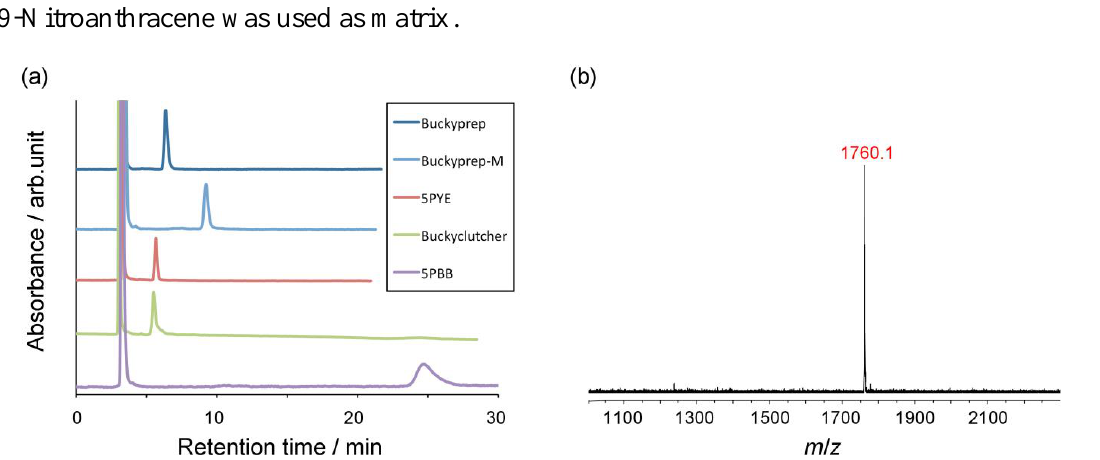
Figure 1. (a) HPLC traces of purified 9 . Conditions: 4.6 mm  250 mm i.d. columns; eluent, toluene 1.0 mL/min; (b) Negative-mode MALDI-TOF mass spectrum of 9